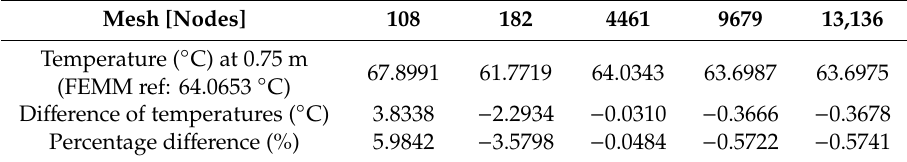
Table 3. Temperature at a point of the tube with two conductivities using [ M λ ] .